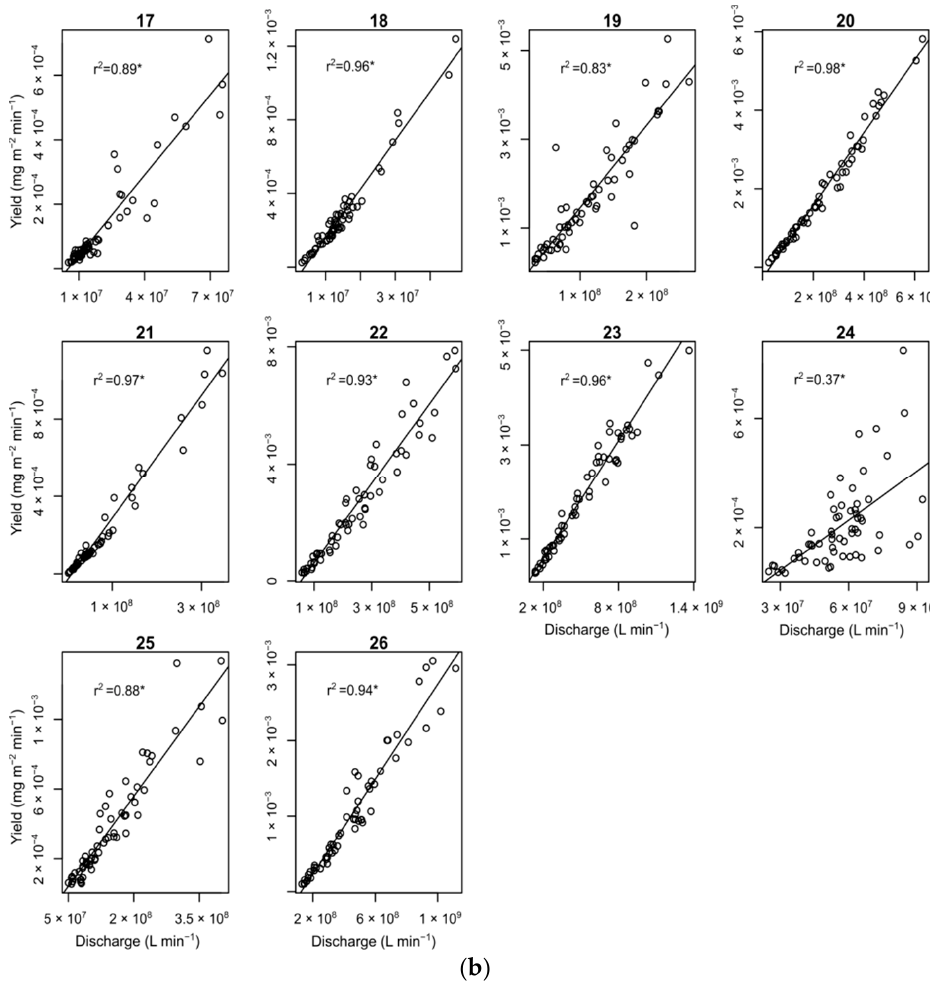
Figure 2. Instantaneous TN yields (mg TN m − 2 min − 1 ) versus instantaneous discharge (L min − 1 ) for the studied rivers. ( a ) is for the first panel, and ( b ) for the second panel. * Significant correlations ( p < 0.05). Table 5. Correlation (r) of Q area , TN concentrations, TN yields with catchment size, precipitation, and land cover types.